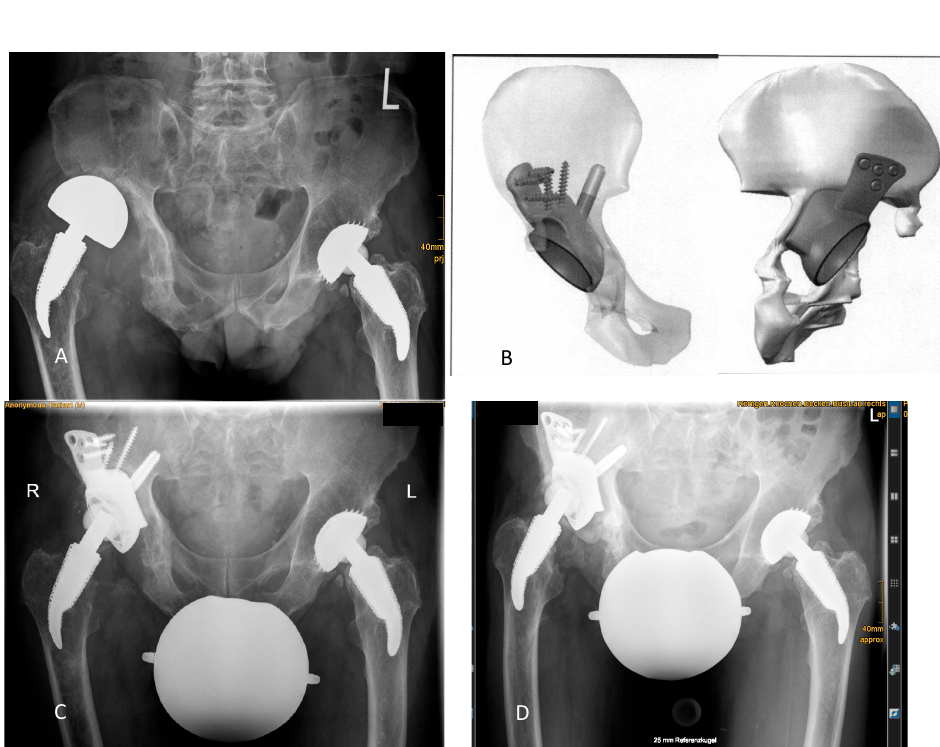
Figure 3. Radiolucency lines without need for revision: ( A ) Preoperative radiographic situation showed the acetabular “up-and-out” defect after implantation of a large head because of acetabular bone loss. ( B ) Anterior to posterior (left) and posterior to anterior (right) views show the intended proximalization of the COR in the virtual 3D reconstruction. The cup is not placed at the level of the Kohler’s tear drop. ( C ) Radiograph after revision and CMAC implantation showed restoration of leg length with a high COR. ( D ) Significant radiolucency lines developed around the whole implant at 3 years of follow-up. Although implant migration cannot be excluded, the patient was not revised because he reported daily walks of up to 10 km supported by a cane. Thus, this case was not considered a failure.